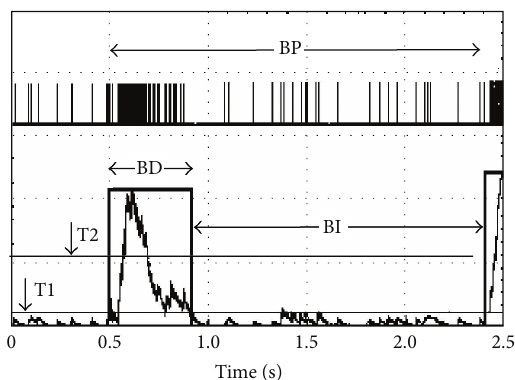
Figure 2: Simulated RC integration with a rise time constant of 70 ms. BD: burst duration; BI: burst interval; BP: burst period. Note the stretching of the burst duration by the slower RC decay. A 10ms adjustment was made to provide a BD closer to the spike